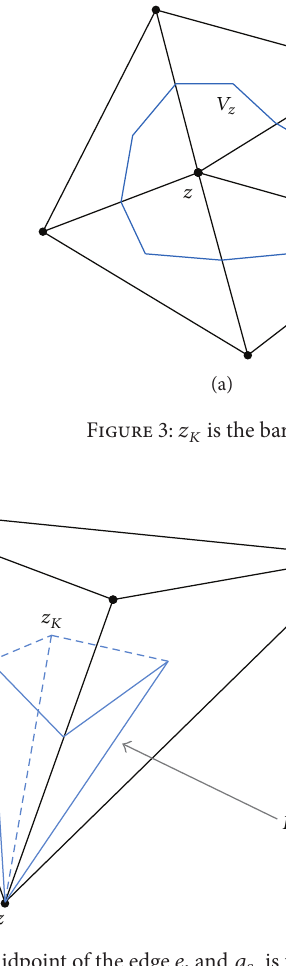
is the barycenter 𝑖